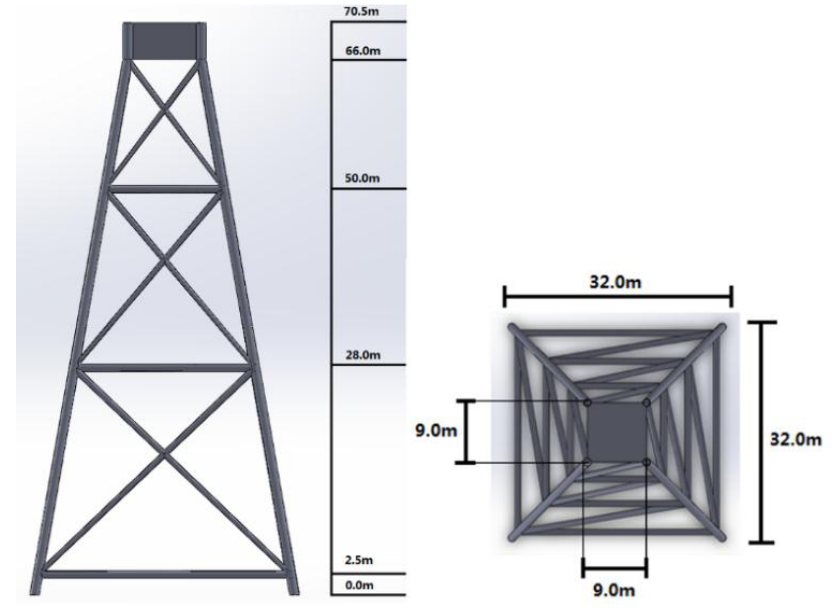
Figure A2. Side and top views of the X-braces (JX) structure.